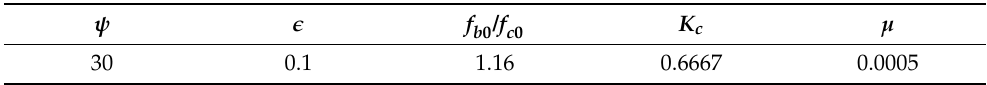
Table 2. Parameters of concrete plastic damage